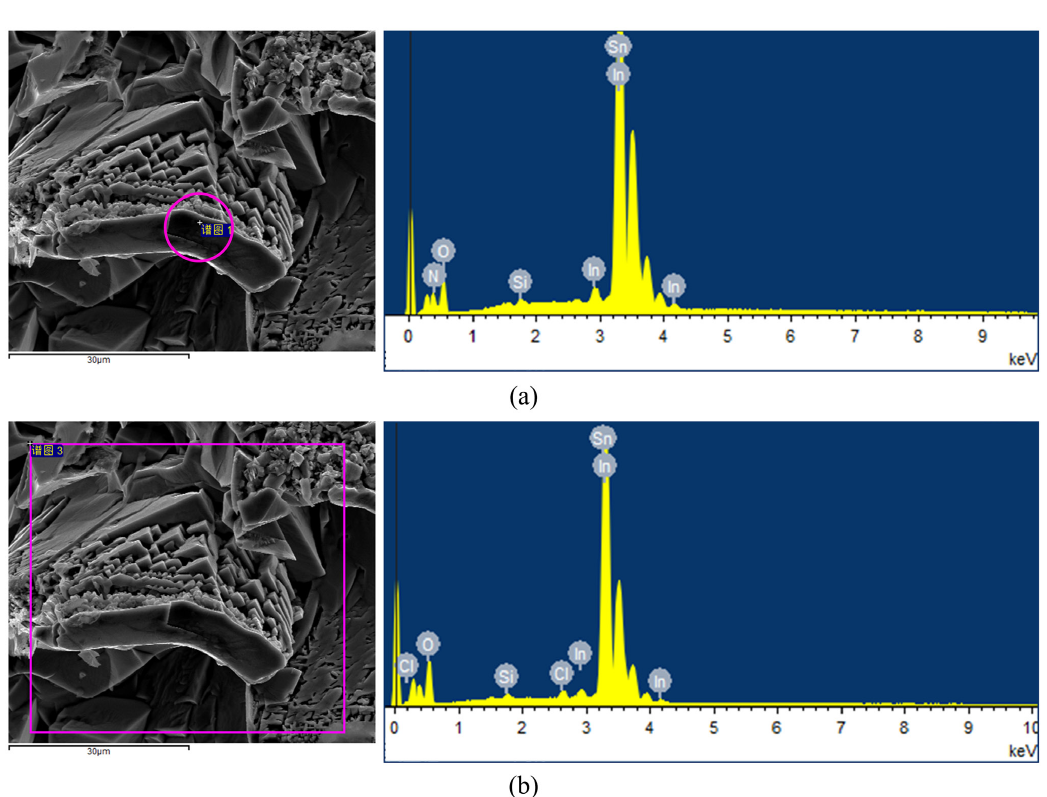
Figure 6. (a) point measurement and (b) region scan of EDS analysis for